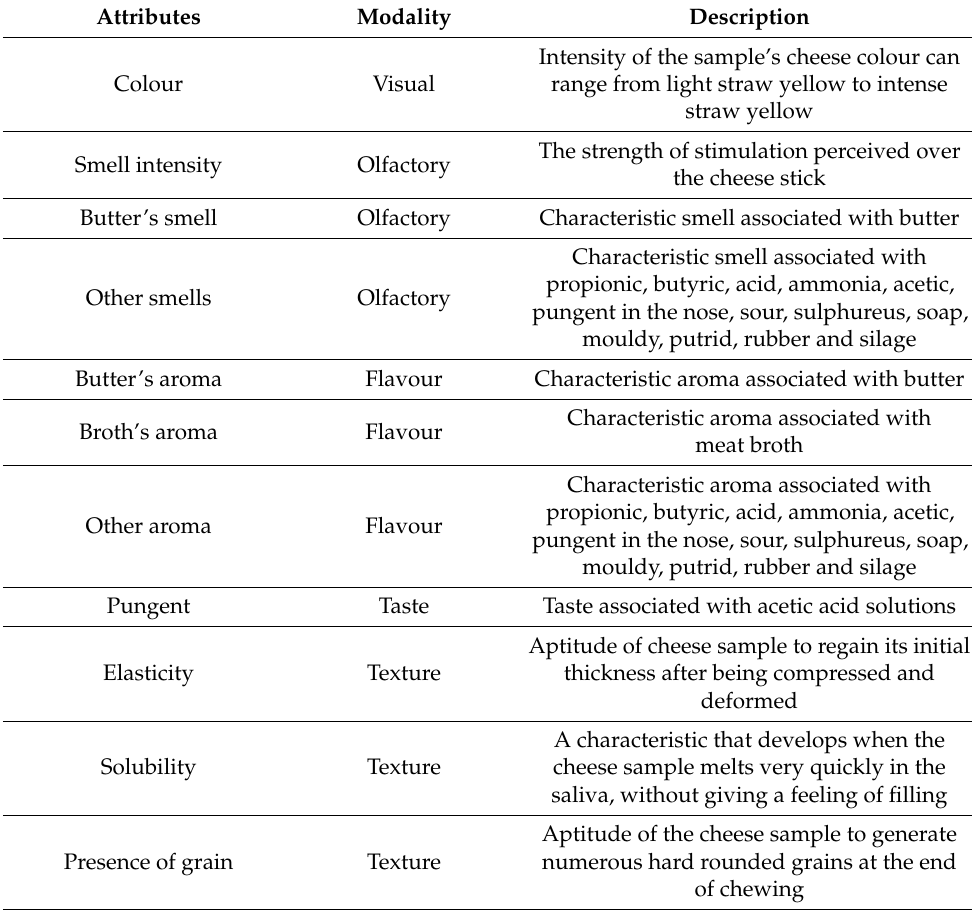
Table 1. Sensory attributes used for the sensory evaluation of Parmigiano Reggiano PDO